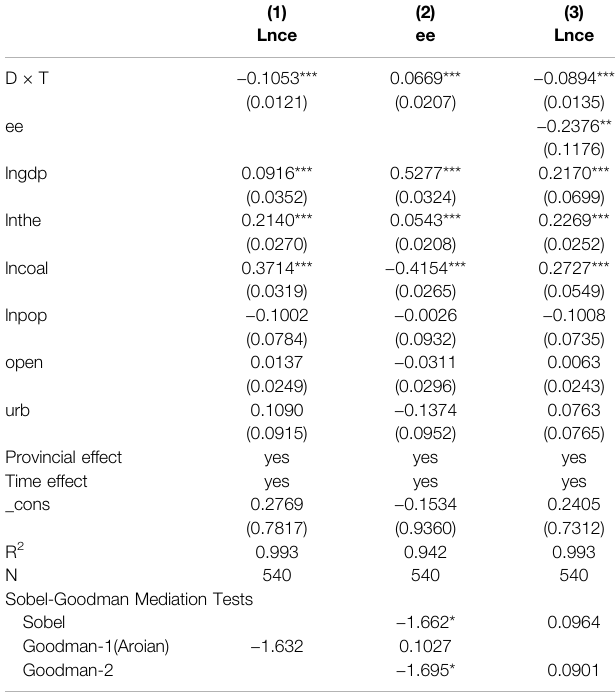
TABLE 9 | Energy ef fi ciency intermediary